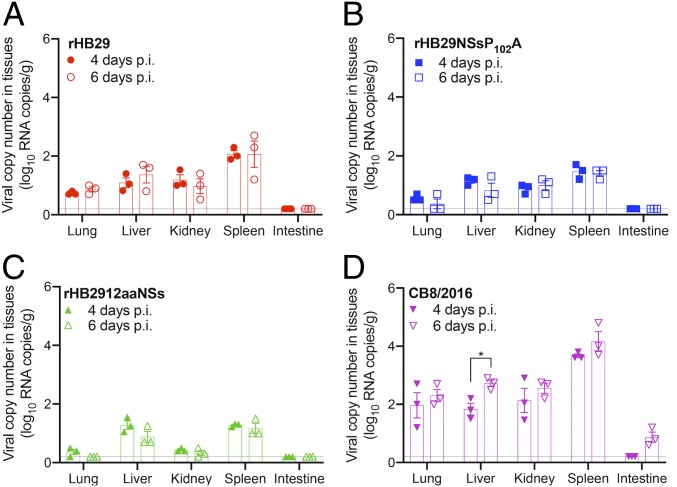
Distribution and viral RNA copy number in tissues of SFTSV-infected ferrets. Tissues (n = 3 per group) from ferrets infected with rHB29 (A), rHB29NSsP102A (B), rHB2912aaNSs (C), or CB8/2016 (D) were collected at days 4 (solid shapes) and 6 p.i. (open shapes), and viral RNA copy numbers were assessed with real-time PCR. Examined tissues included lung, liver, kidney, spleen, and intestine. The asterisks indicate significance compared to each day p.i. sample by the 2-tailed, unpaired t test (*P = 0.0195). Each experiment was performed for 3 biological and 3 technical repeats.